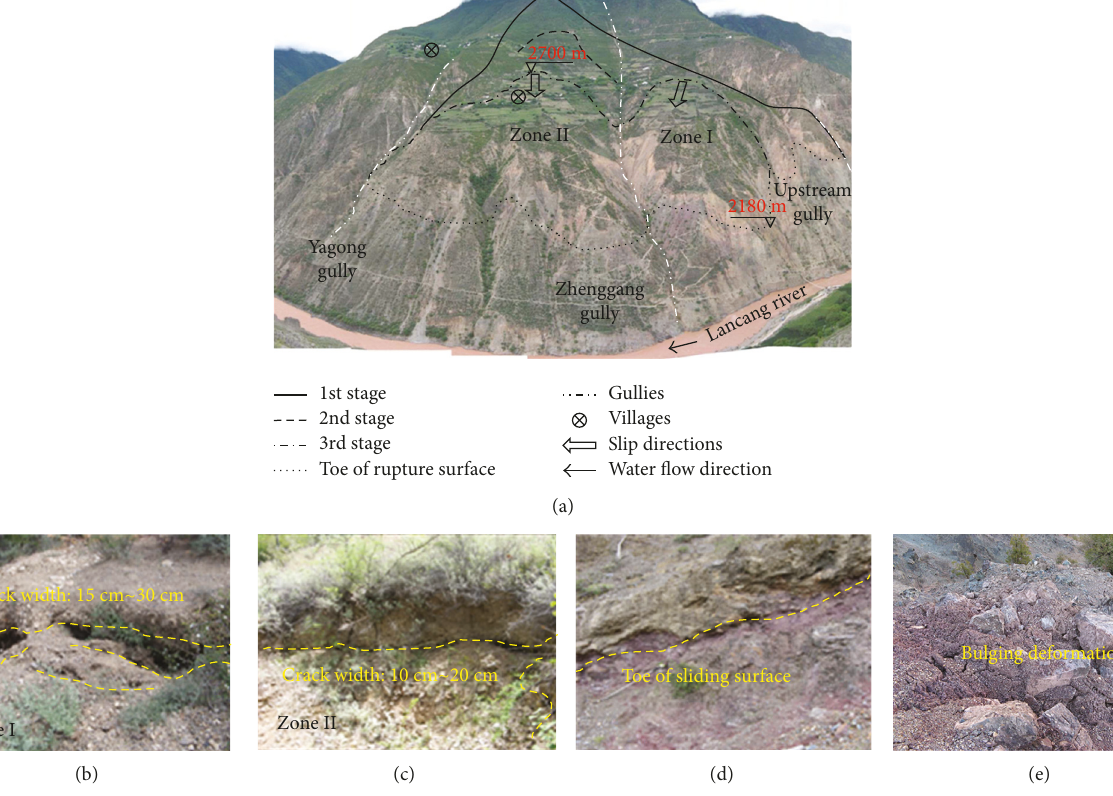
Figure 3: The topographic and geomorphic features of the Zhenggang